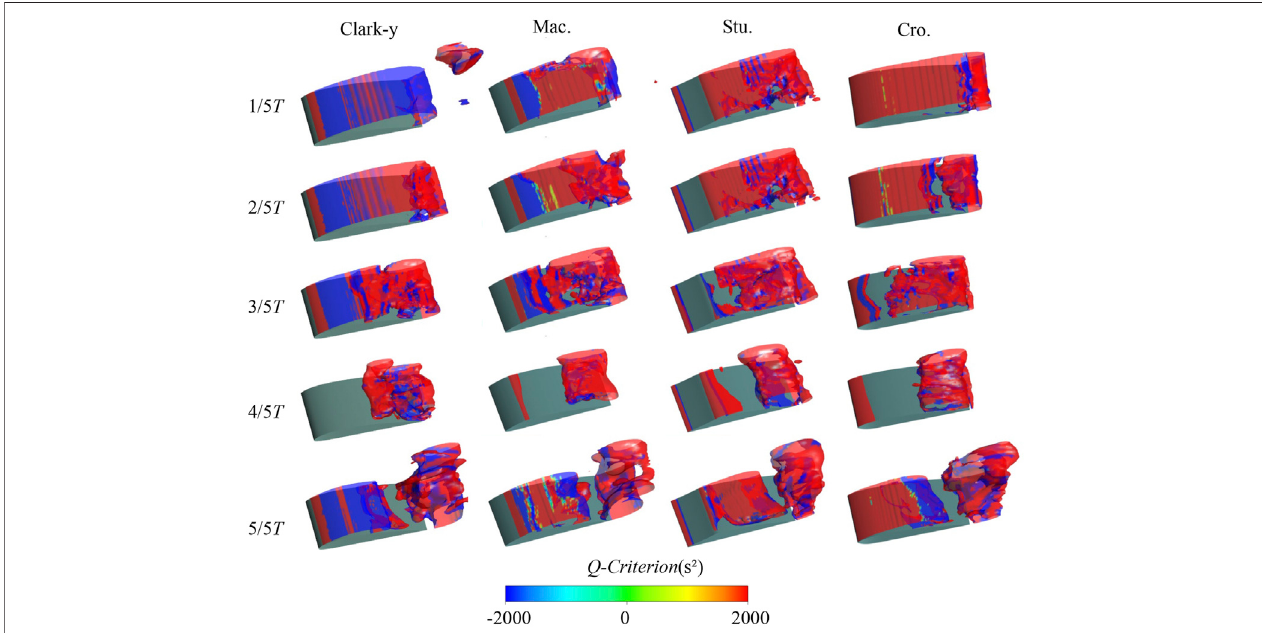
FIGURE 9 | Comparison of the vortex structures around the four hydrofoils based on Q criterion.